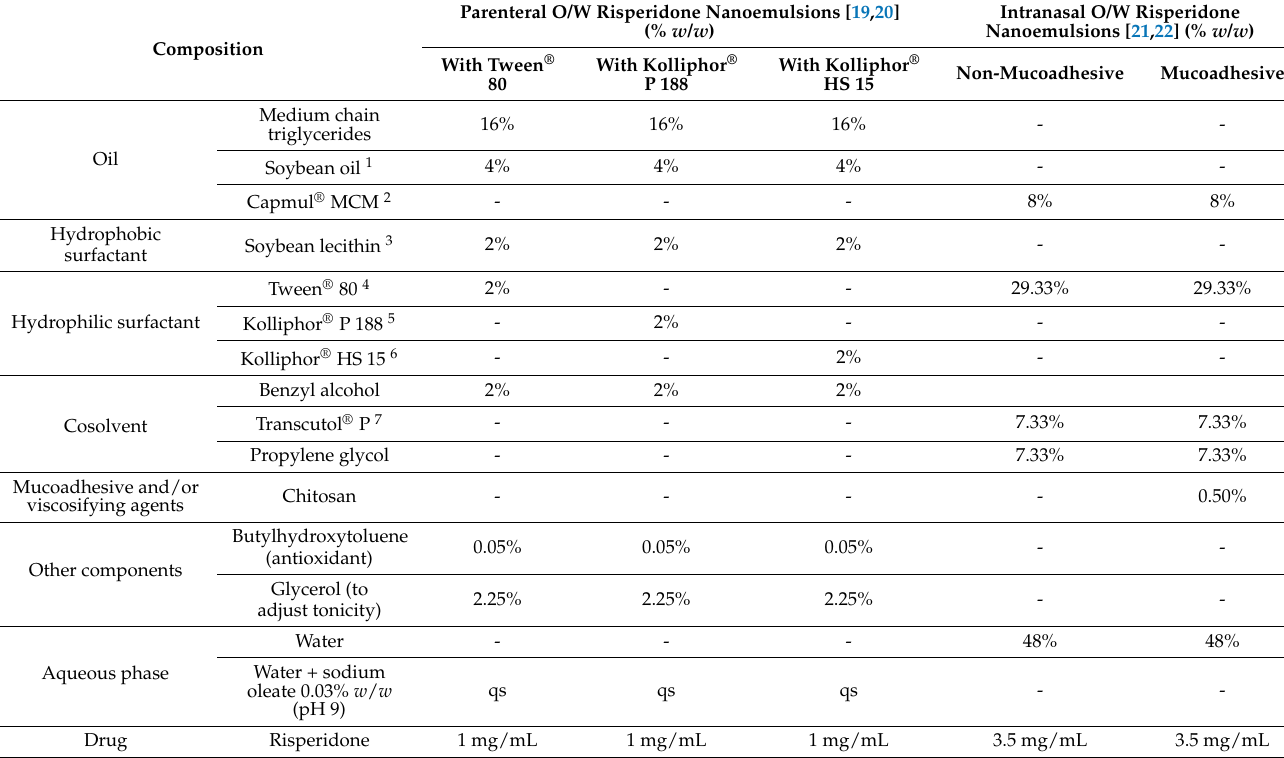
Table 3. Detailed composition of the risperidone parenteral and intranasal nanoemulsions. Excipient and drug quantities and units are shown as reported in the respective articles ( w / w % for excipients, and mg/mL for drugs). For the excipients the brand name was used (when